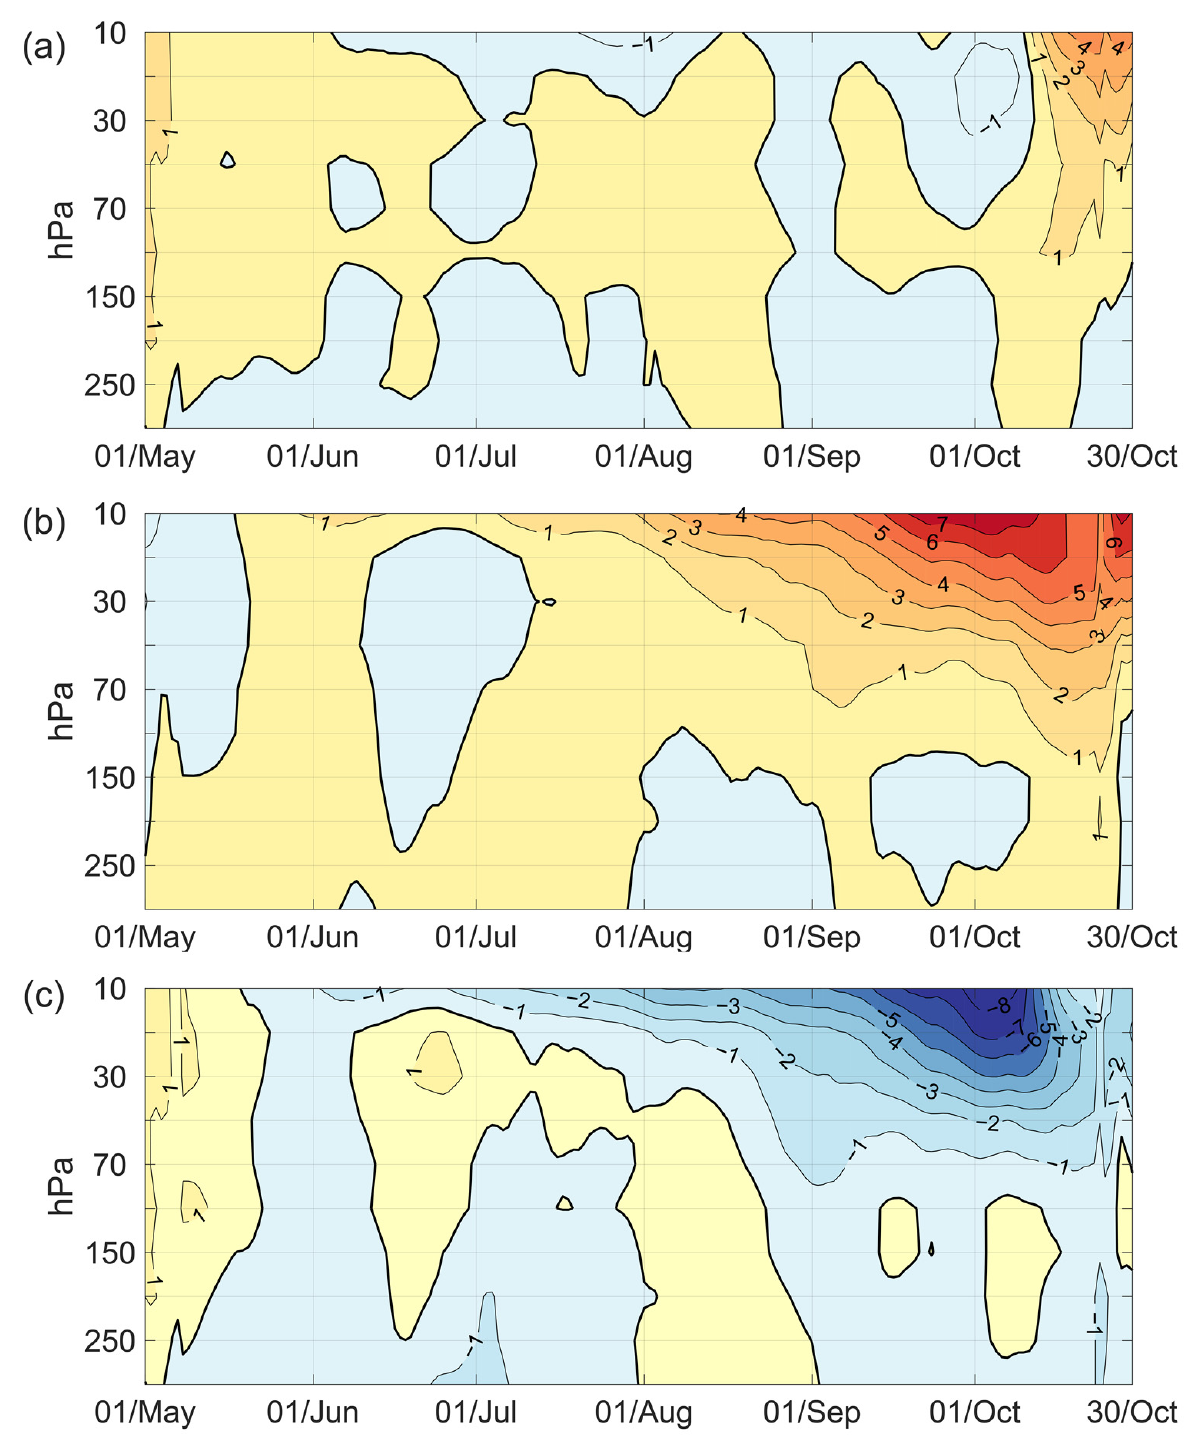
Figure 13. Composite vertical sections of daily anomalies in Antarctic stratosphere temperature averaged between 70 and 90° S for ( a ) Eastern Pacific (EP) and ( b ) Central Pacific (CP) El Niño events and ( c ) difference between composites of EP and CP El Niño events. Values are smoothed with a 15-day running mean. Contour interval is 1K. Black bold line indicates zero isoline.